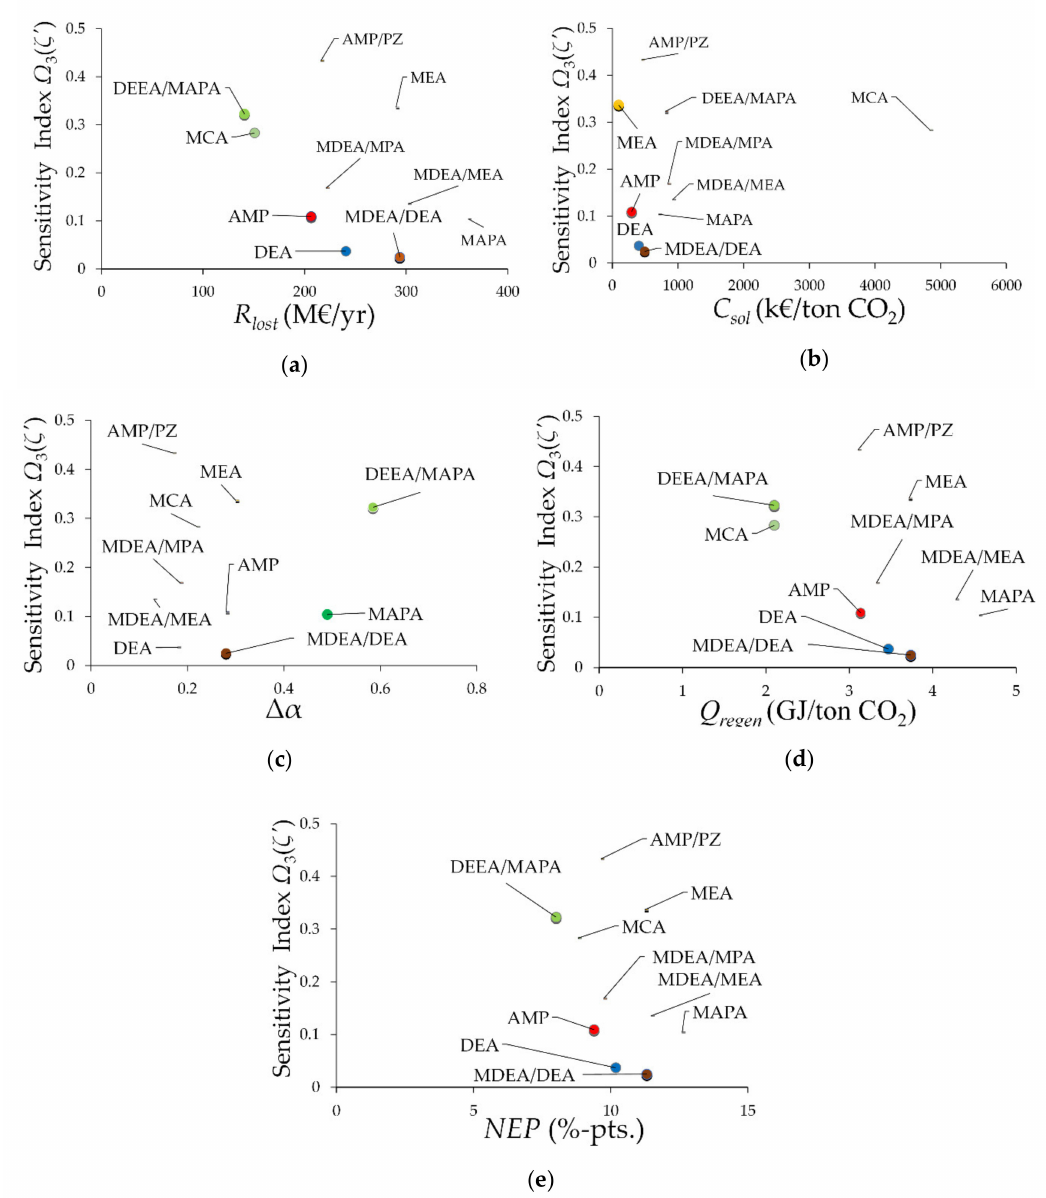
Figure 6. Pareto front between the sensitivity index Ω 3 ( ζ (cid:48) = 0.2 ) and ( a ) R lost , ( b ) C sol , ( c ) ∆ α , ( d ) Q regen , and ( e ) NEP . Marks other than colored circles indicate undesirable